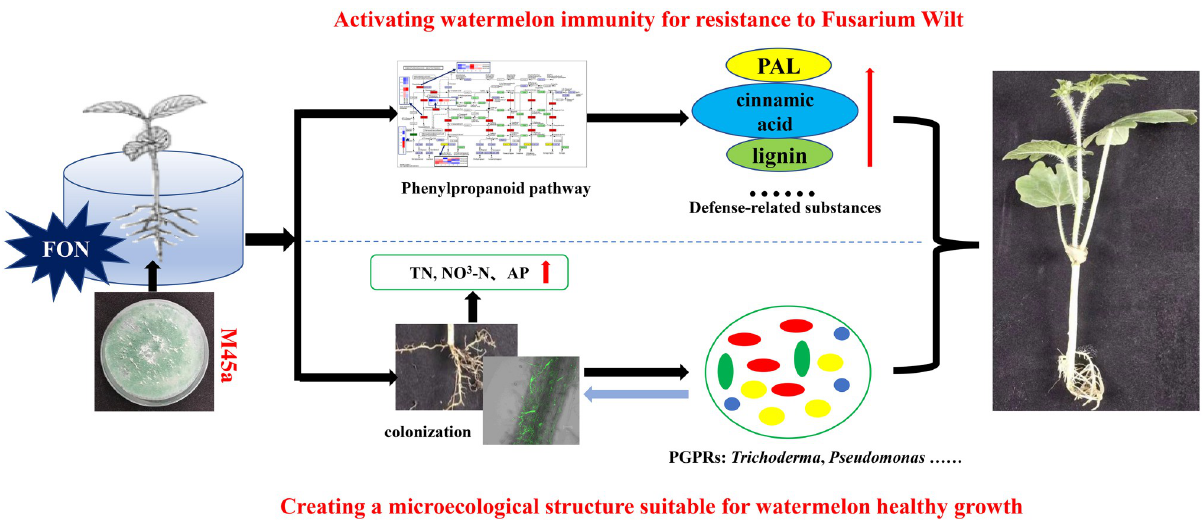
Fig 7. The predicted pathway of inhibiting Fusarium wilt and the biocontrol mechanism of T . asperellum M45a with its host fungus F . oxysporum